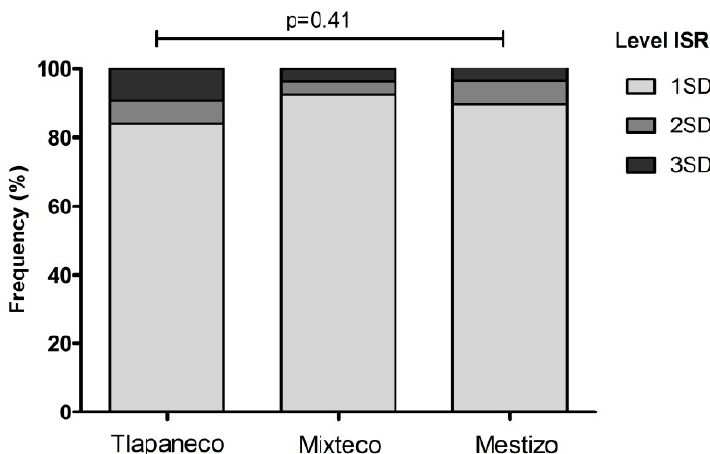
Figure 2. Distribution of positive cases to measles antibodies according to standard deviation (SD) levels of index standard ratio (ISR) in the three ethnic groups. Data are reported as n (%). Chi-square test. Significance value at p < 0.05.